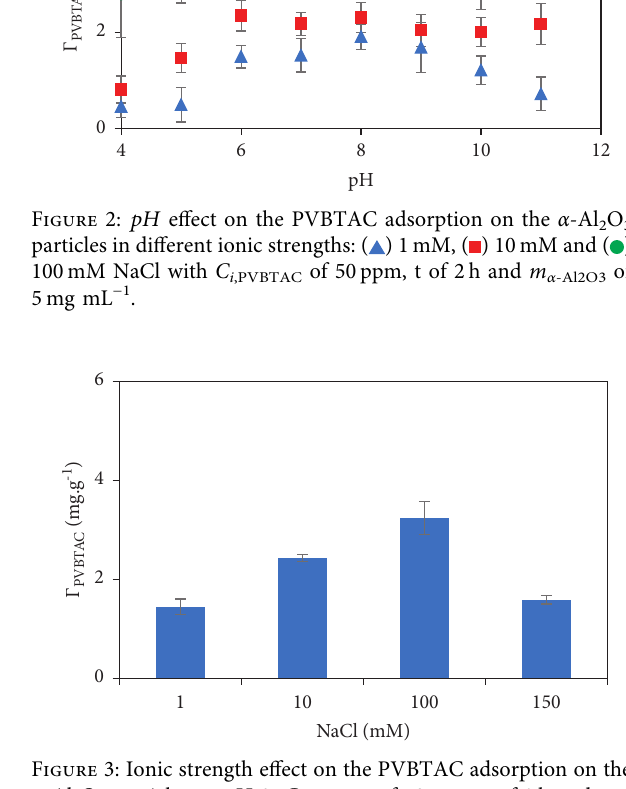
Figure 3: Ionic strength effect on the PVBTAC adsorption on the α -Al 2 O 3 particles at pH 8, C i ,PVBTAC of 50 ppm, t of 2 h and m α - − 1 Al2O3 of 5mg mL